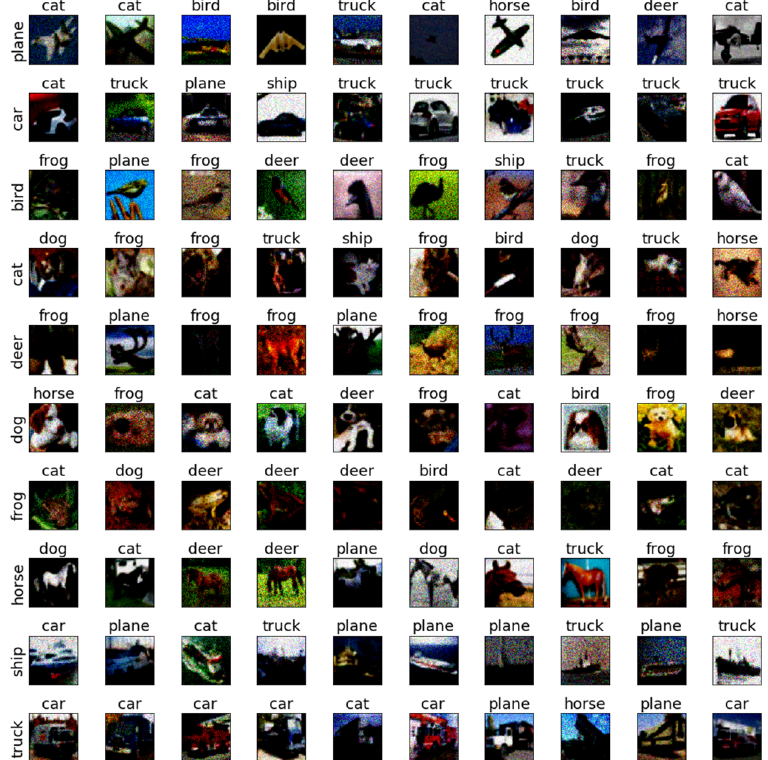
Figure 12. The adversarial examples of BMI-FGSM for Cifar10 and AlexNet.